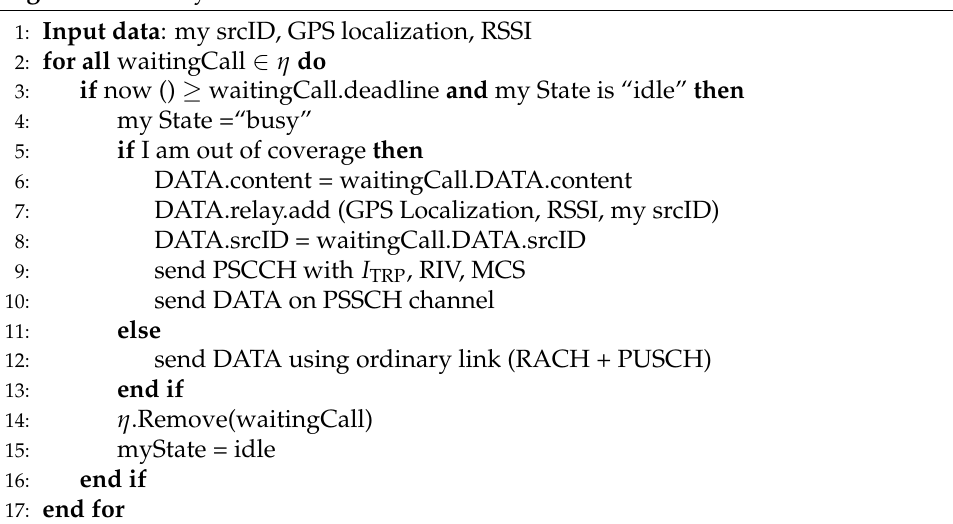
Algorithm 3 Every one